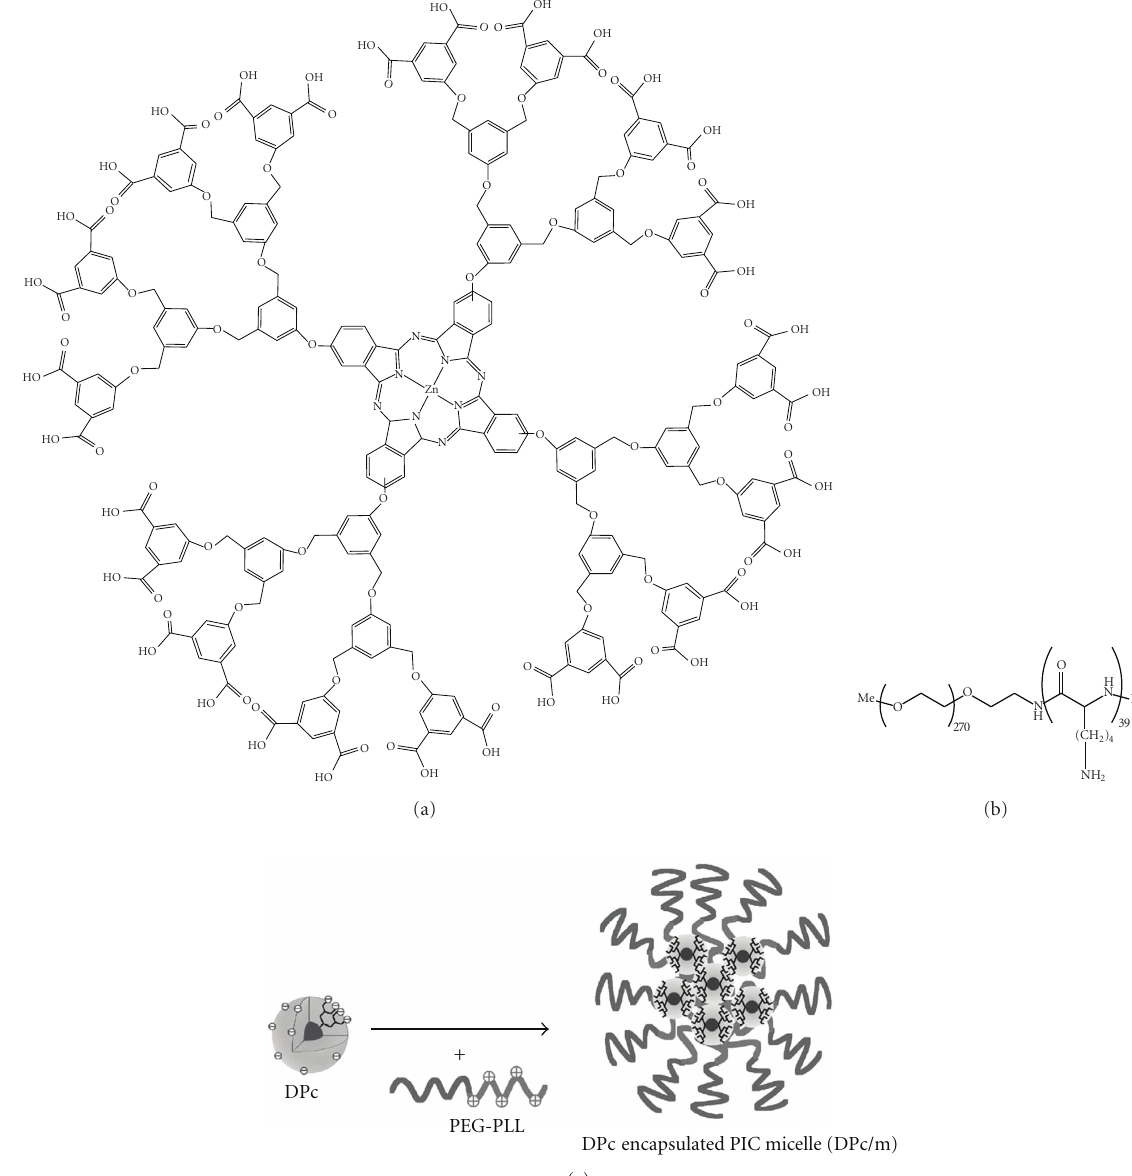
Figure 11: Chemical structures of anionic dendrimer PSs (a) and poly(ethylene glycol)-poly(L-lysine) (PEG-PLL) block copolymer (b). Dendrimer PSs-encapsulated ionic complex micelle was formed by mixing PSs and PEG-PLL at a charge stoichiometric ratio (c) [17].